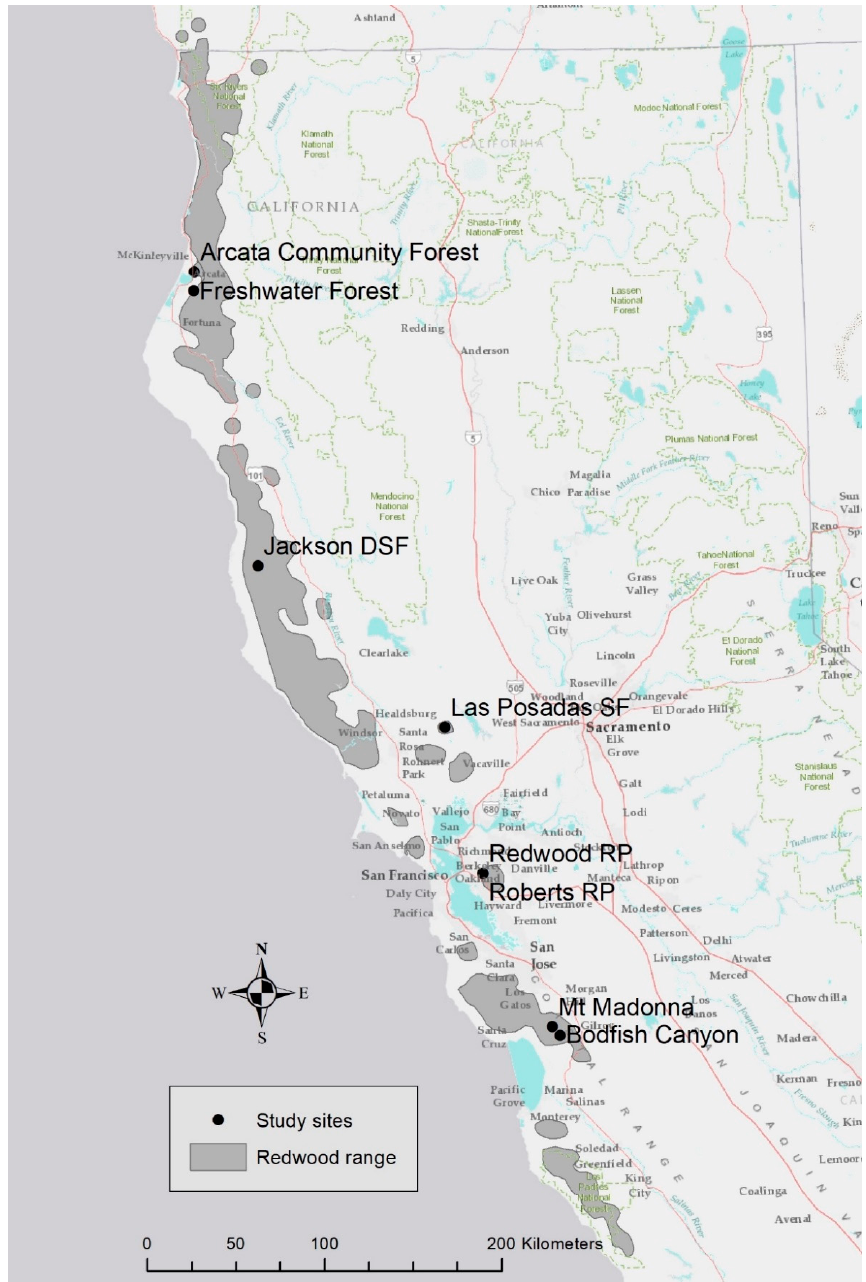
Figure 1. Study sites and approximate range of redwood in northern California and southern Oregon. Table 1. Redwood bark thickness study site location information.